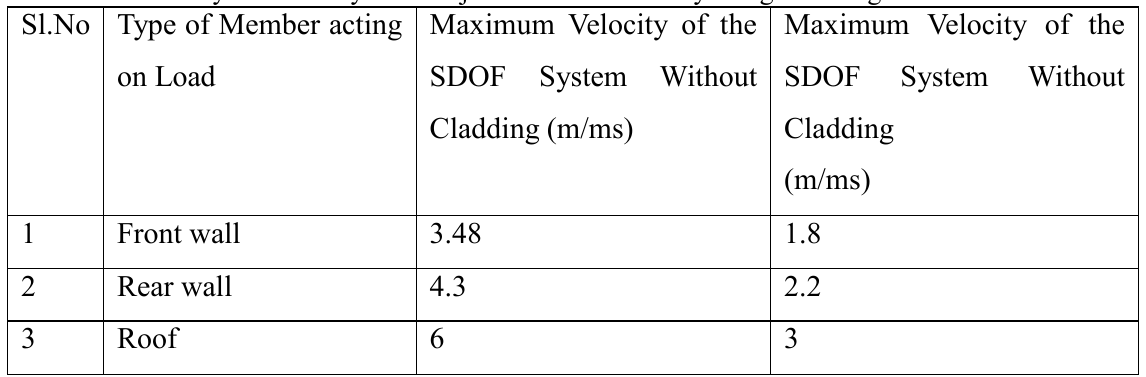
Reduction of velocity of SDOF system subjected to Blast load by using Cladding material. Sl.No